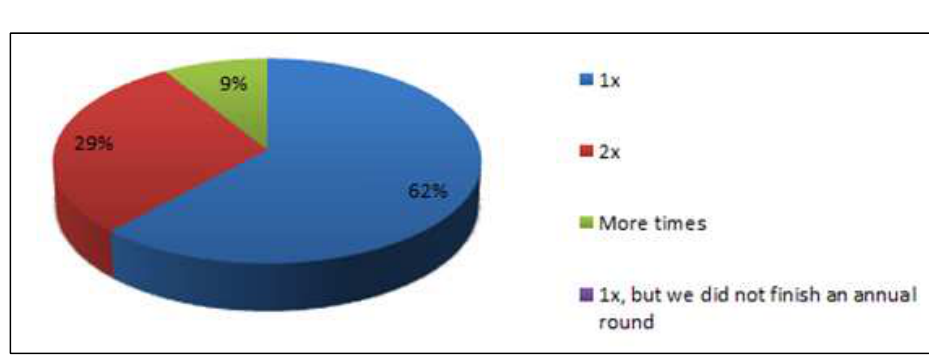
Fig. 3 Results of question 2: How many times had your organisation participated the competition?